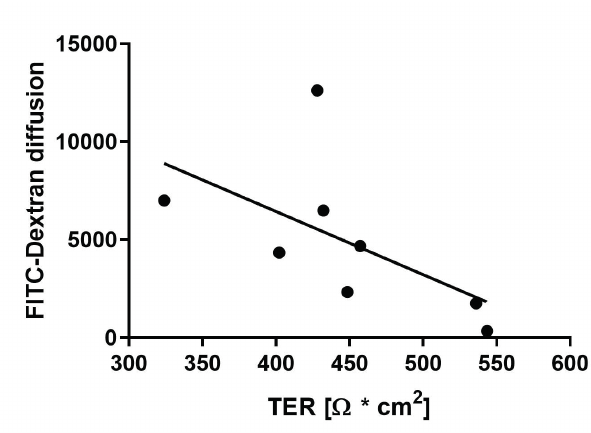
Figure 3. Negative correlation of TER and FD4 passage. The FD4 passage is expressed as the measured fluorescein intensity. For the measure- ment, we used 8 ALIs with reproduceable intensity measurements of fluorescence absorption. TER is mentioned in [Ω * cm 2